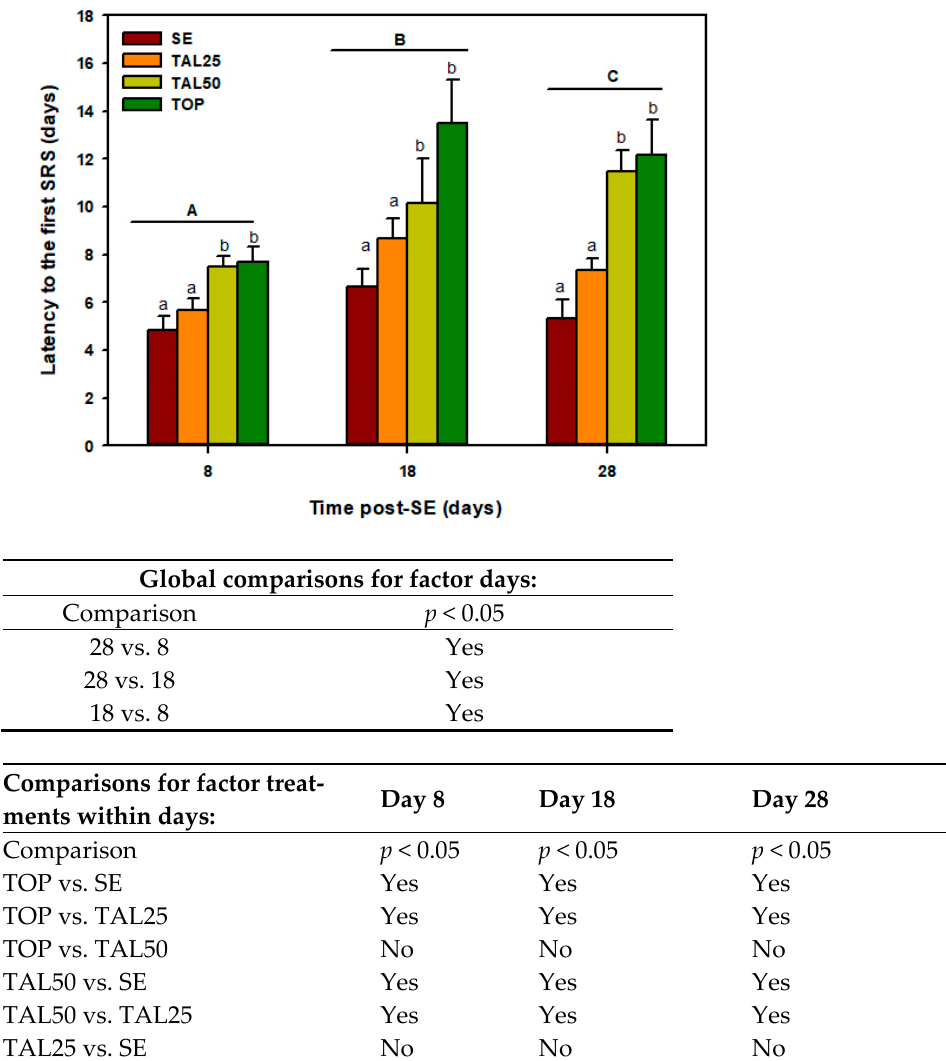
Figure 1. Effect of thalidomide (TAL) and topiramate (TOP) on the latency to the first spontaneous recurrent seizure observed 8, 18 and 28 days after status epilepticus (SE). Each bar represents the mean + S.E.M. of 6 animals per group. Different capital letters denote global comparisons p ≤ 0.05 among times, lowercase letters designate p ≤ 0.05 among treatments within times, two-way ANOVA followed by Student-Newman-Keuls post-hoc test. The tables show the results of statistical analysis.